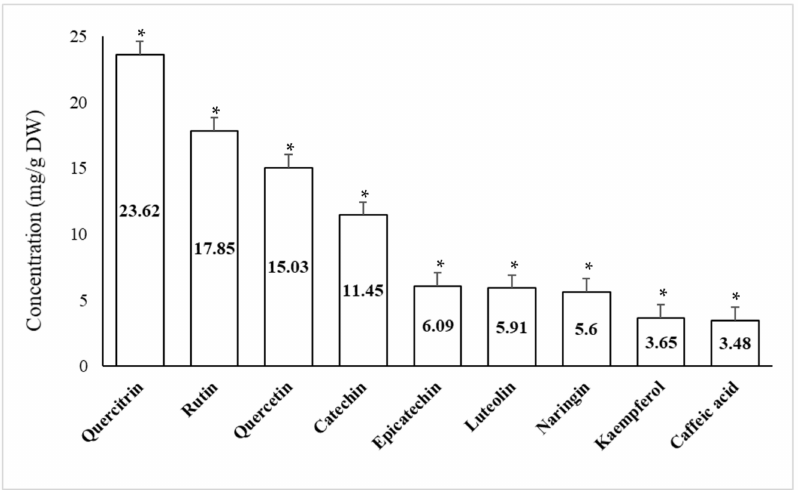
Figure 3. Common phenolic compounds of pomegranate peel powder (Highly significant = * p < 0.01, n = 3).